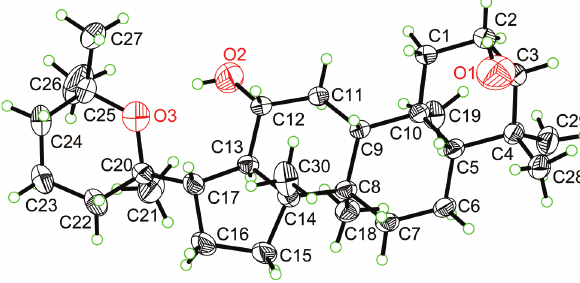
Table 1: Data collection and handling.